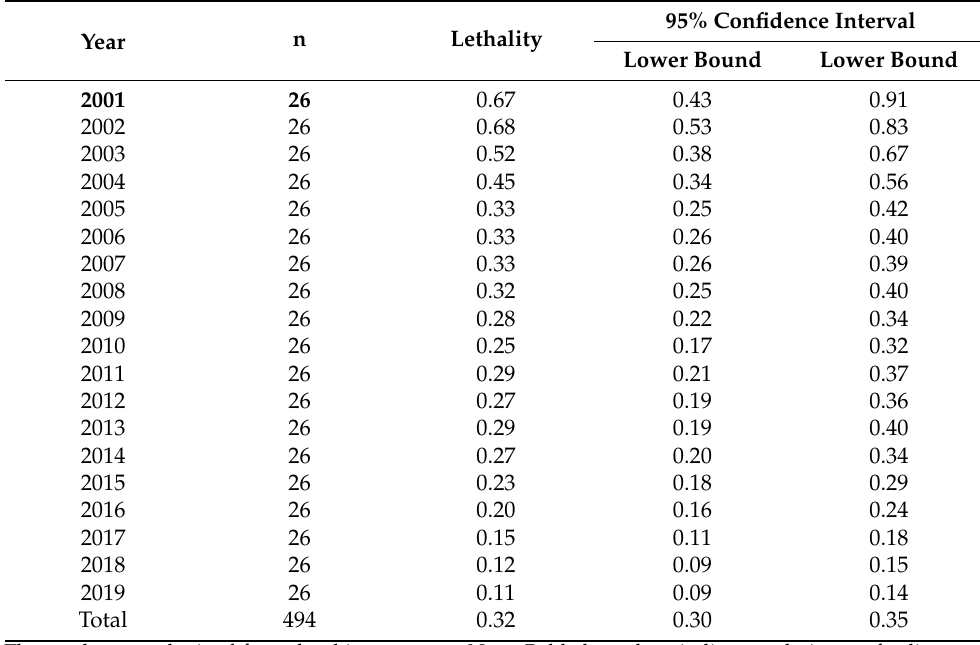
Table 2. Malaria case-fatality rate (Deaths per 100 cases) in DRC,